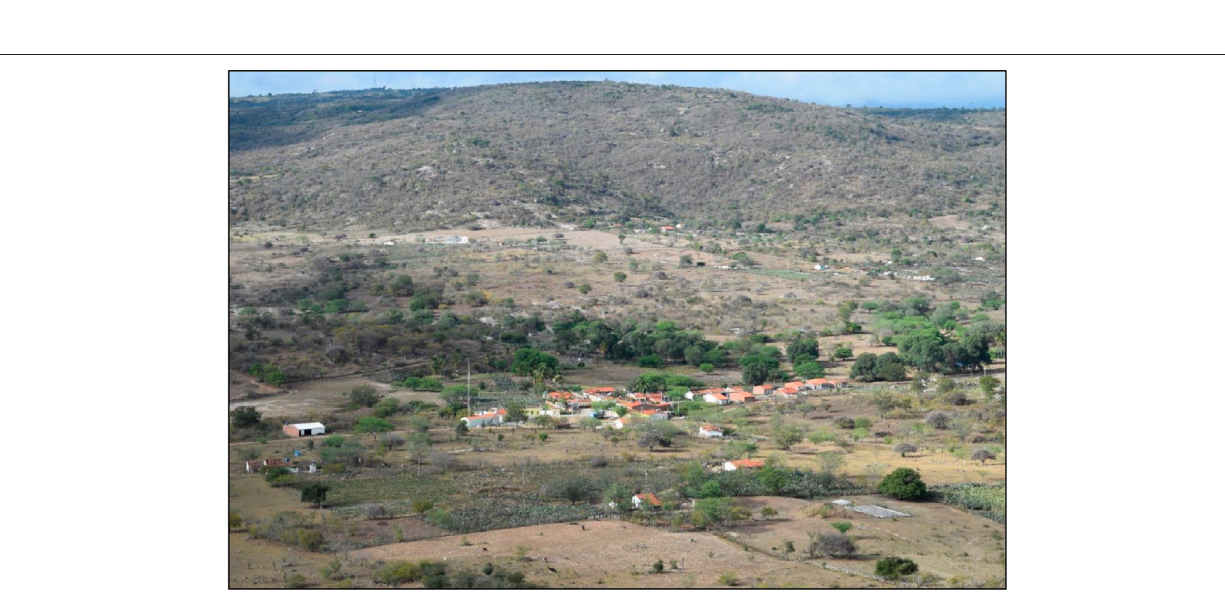
Frontiers in Environmental Science |